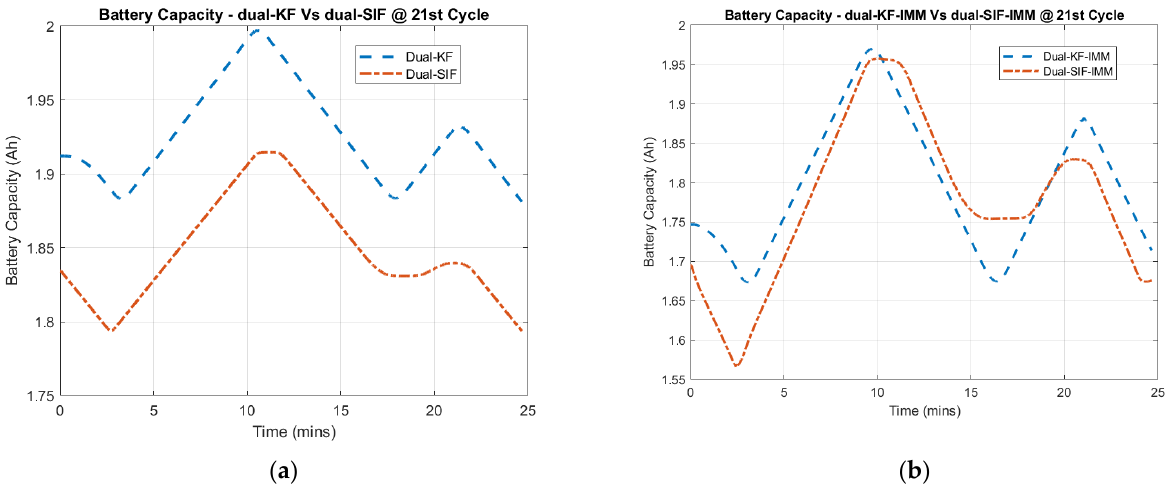
Figure 14. ( a ) Dual-KF and dual-SIF battery capacity estimates at cycle 21. ( b ) Dual-KF-IMM and dual-SIF-IMM battery capacity estimates at cycle 21.